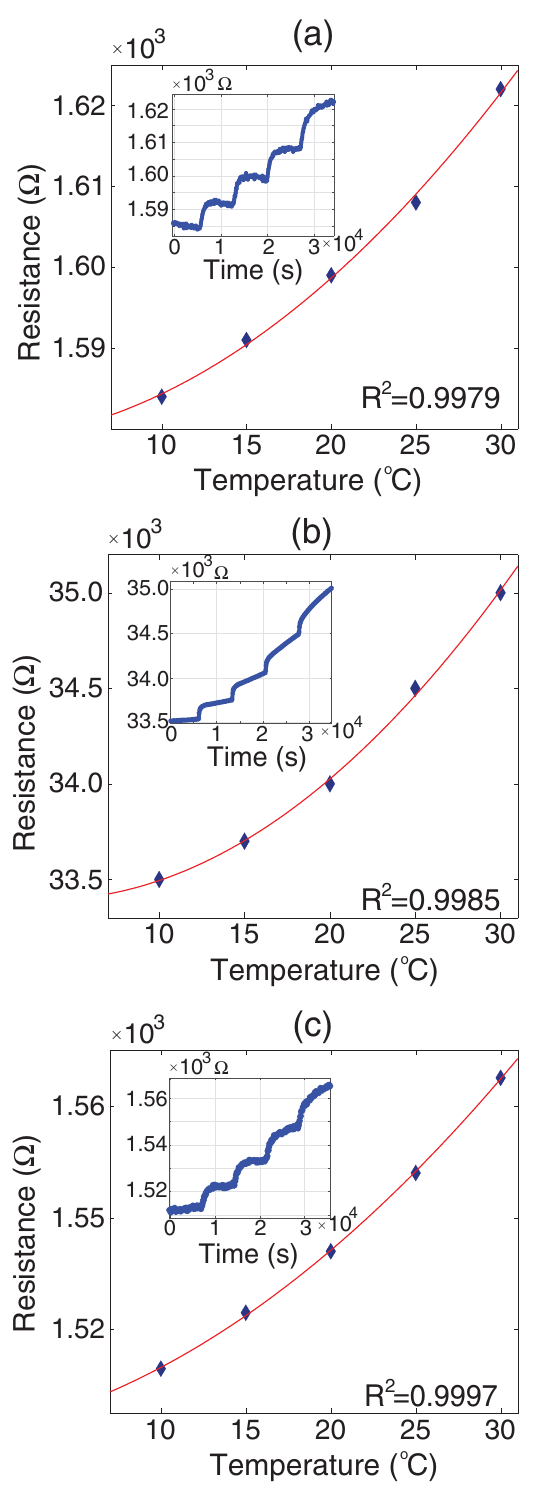
Figure 4. Resistance change as a function of time and temperature for the three different graphene sensors: ( a ) a graphene sensor on a SiO 2 /Si substrate, ( b ) a graphene sensor on a SiN membrane, and ( c ) the suspended graphene sensor (Y axis for all figures is resistance